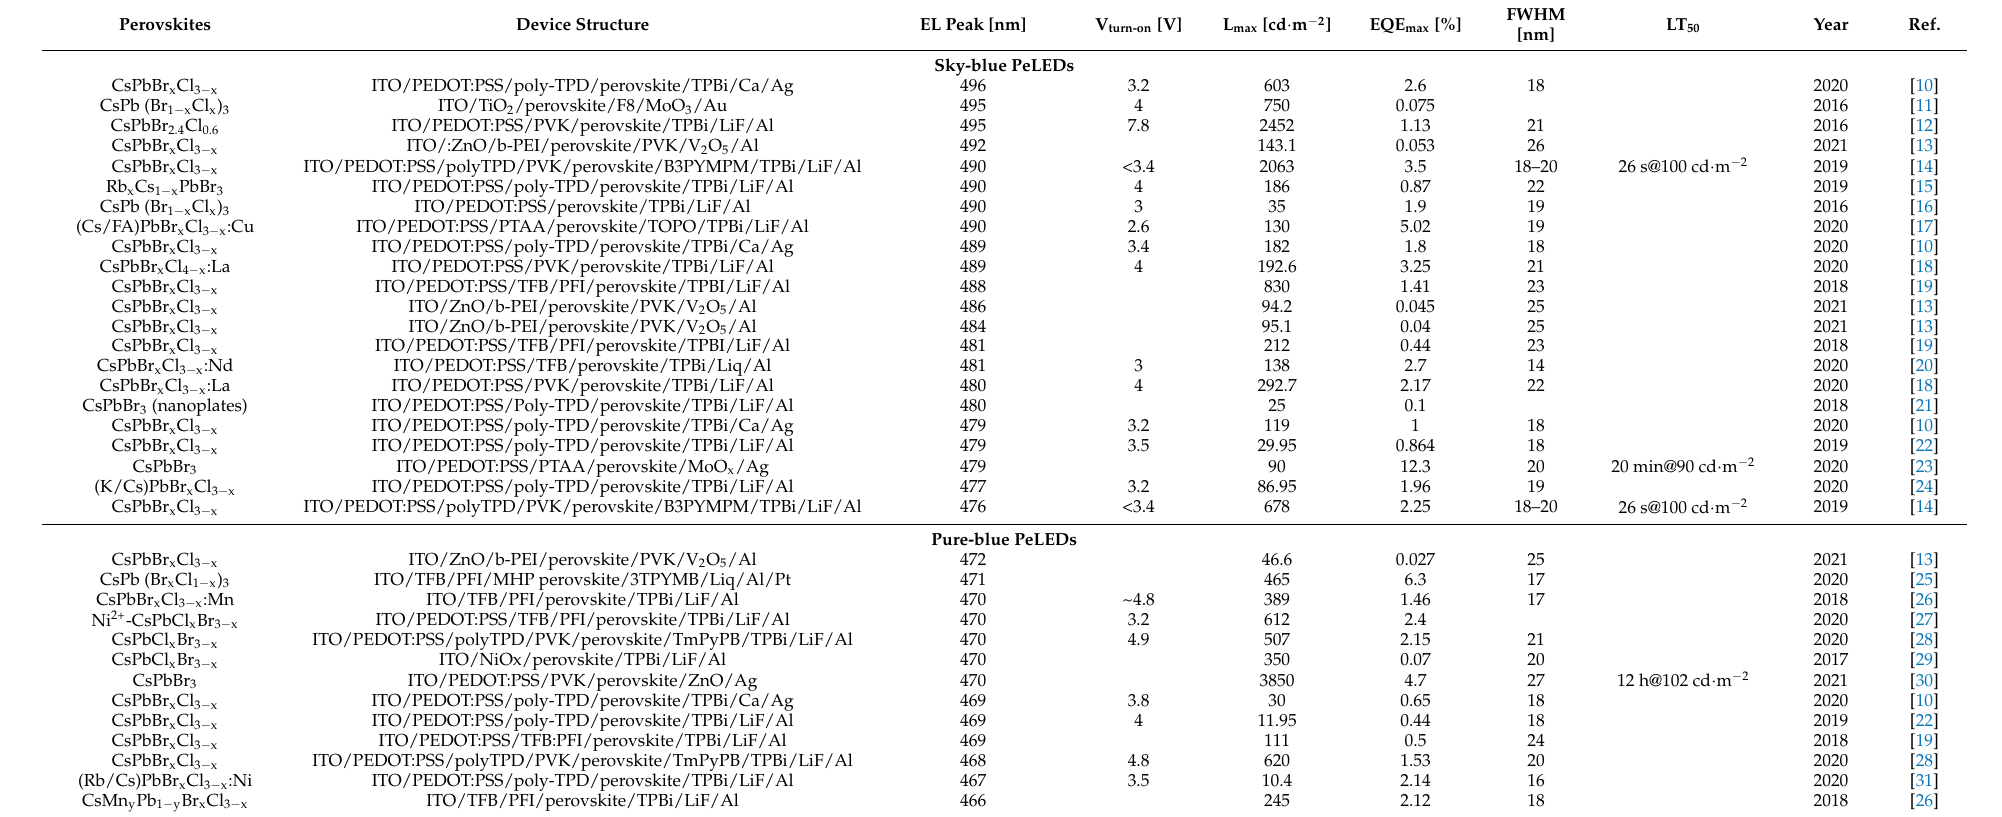
Table 1. The overview of the performance of some blue PQD-LEDs in recent years. Perovskites Device